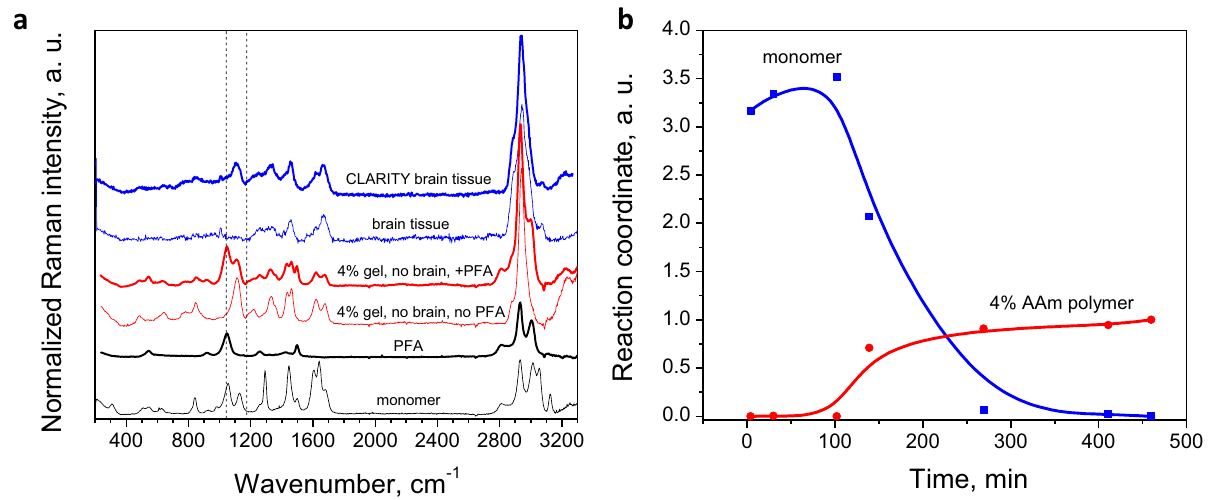
Figure 3. Formation of brain-polymer hybrid ex vivo, monitored by Raman spectroscopy in a wide spectral range: ( a ) Raman spectra of monomer (black line), PFA (thick black line), 4% AAm PA gel without PFA (thin red line) and with PFA (thick red line), brain tissue (thin blue line) and CLARITY brain tissue (thick blue line). Spectra vertically offset for ease of viewing. Raw data was corrected by subtracting the water signal and